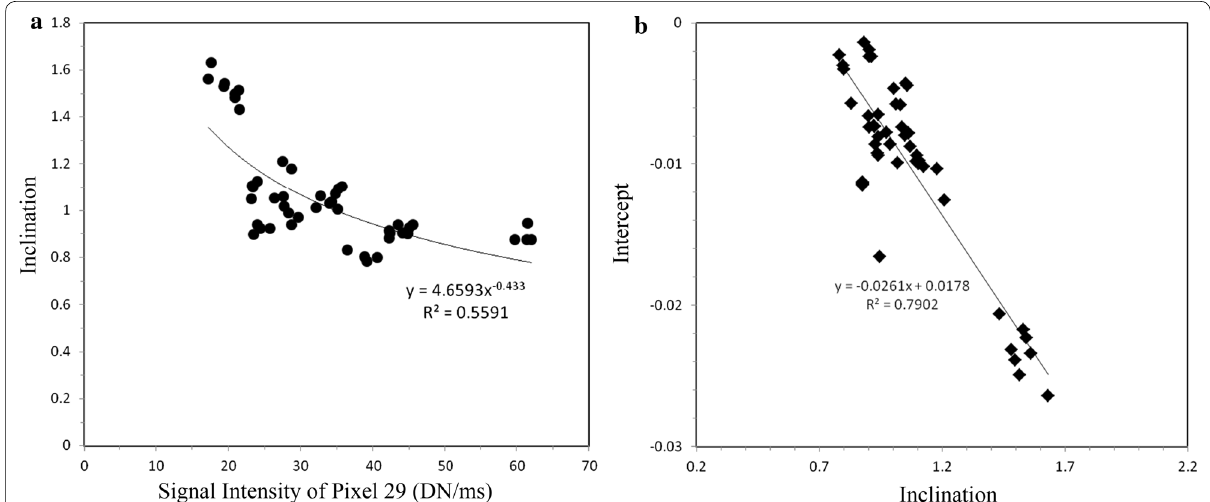
Fig. 4 Correlations among the signal intensity of pixel number 29, and the inclination and y-intercept values obtained by the linear regression analyses of NIRS3 and FT-IR reflectance data (e.g., Fig. 2b). The signal intensity is normalized by integration time. All meteorite data recorded by NIRS3 are used in a , but the data of Allende are excluded in b